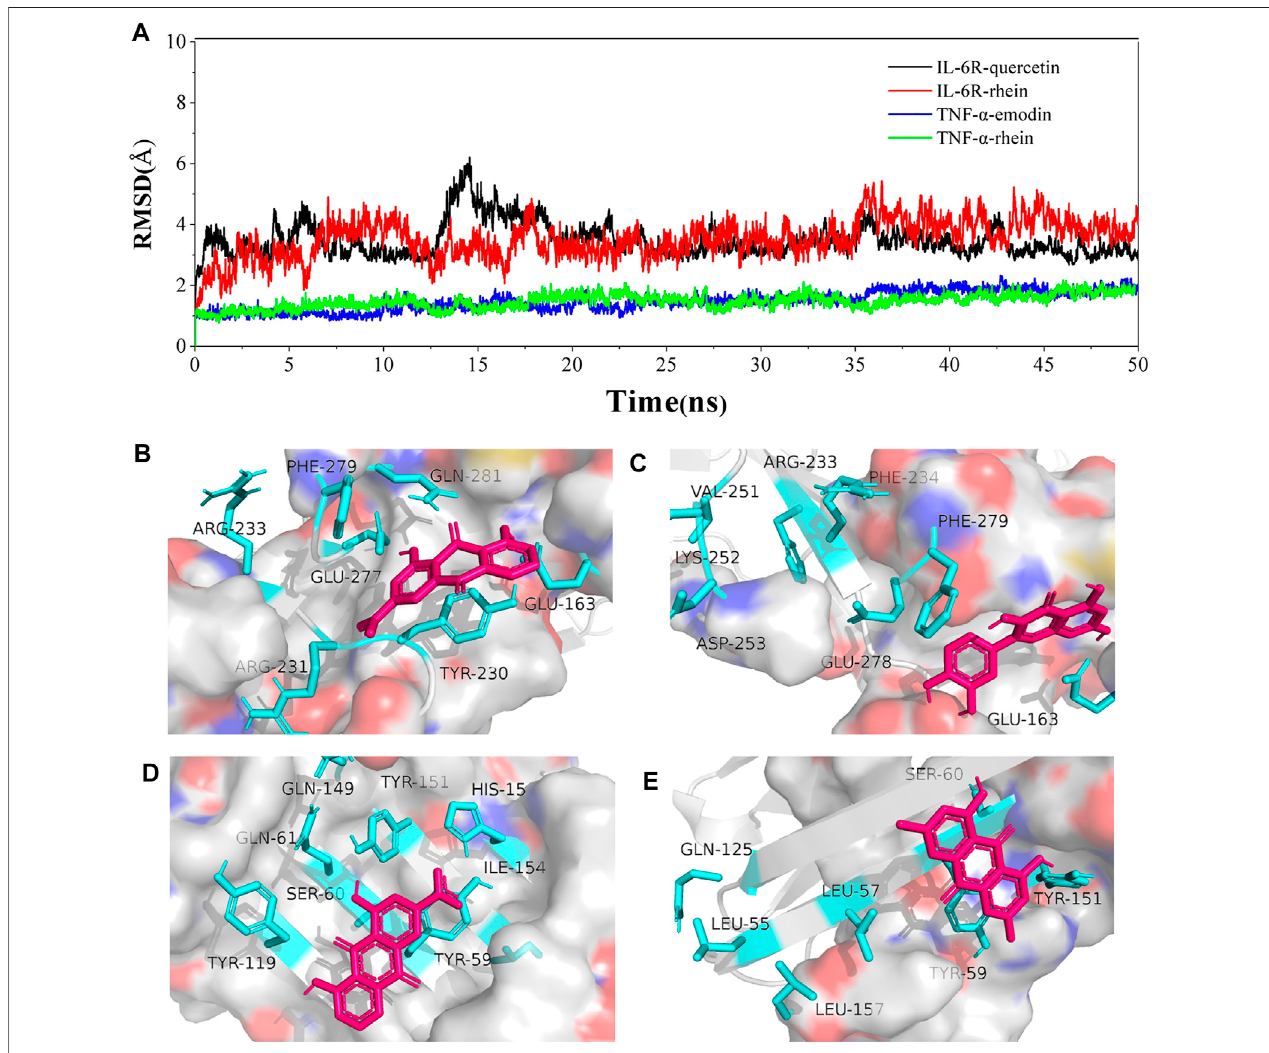
FIGURE 8 | Molecular dynamics simulation study. (A) RMSD of the active compound – protein complex in 50 ns, which is made up of a number of α -carbon (C α ) atoms, throughout the simulations; (B,C) Binding interaction patterns of rhein and quercetin with IL-6R; (D,E) Binding interaction patterns of rhein and emodin with TNF- α .